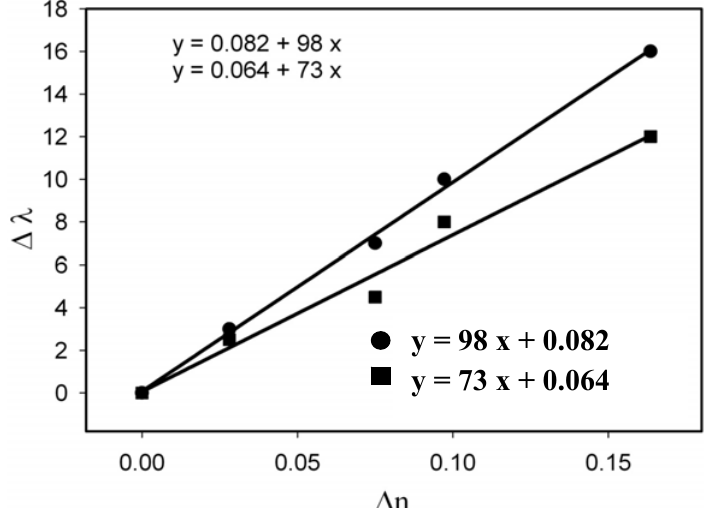
Figure 10. Refractive index sensitivity of the non-annealed ( ) and annealed ( ) thermally- reduced samples.